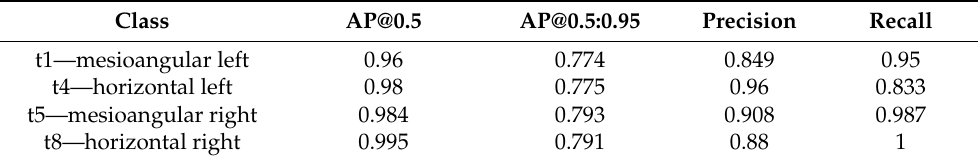
Table 3. Inter-class detection performances for the solution with